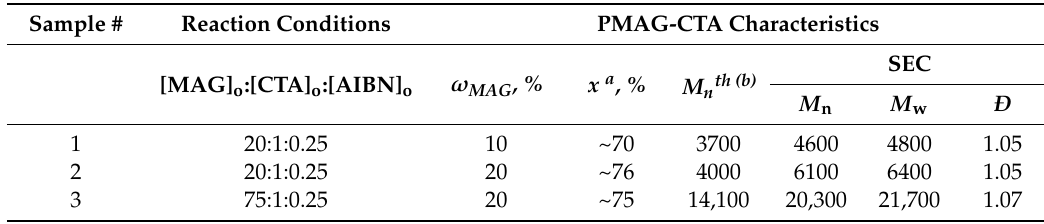
Table 1. RAFT-polymerization of 2-deoxy-2-methacrylamido-D-glucose: Characteristics of homopolymers depending on the synthesis